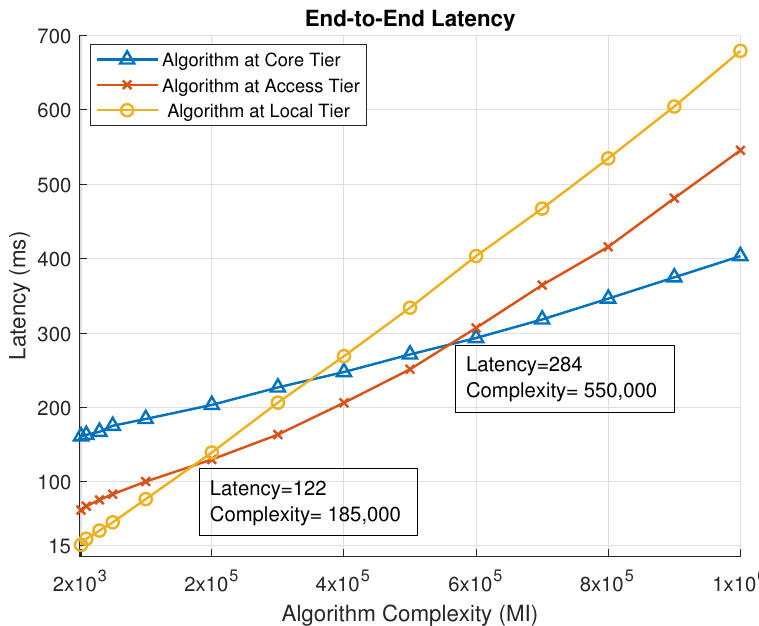
Figure 4. End-to-end latency: without the blockchain.